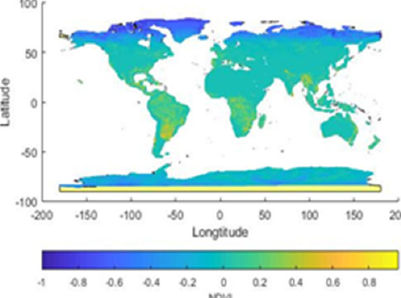
Figure 2. AVHRR NDVI monthly data of January to March 2017